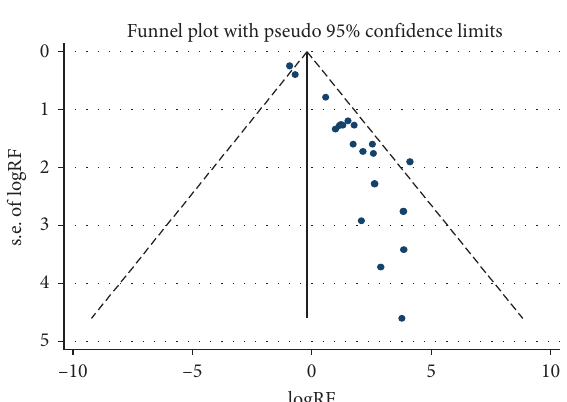
Figure 5: Funnel plot for publication bias for the prevalence of replacement feeding practice.